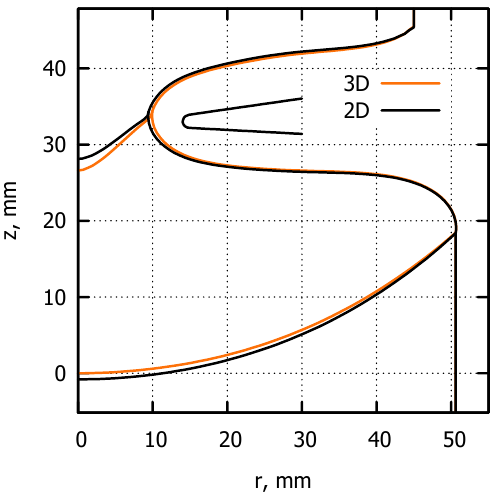
Figure 7. Comparison between shapes of the phase boundaries for optimized 2D and 3D EM simulations.